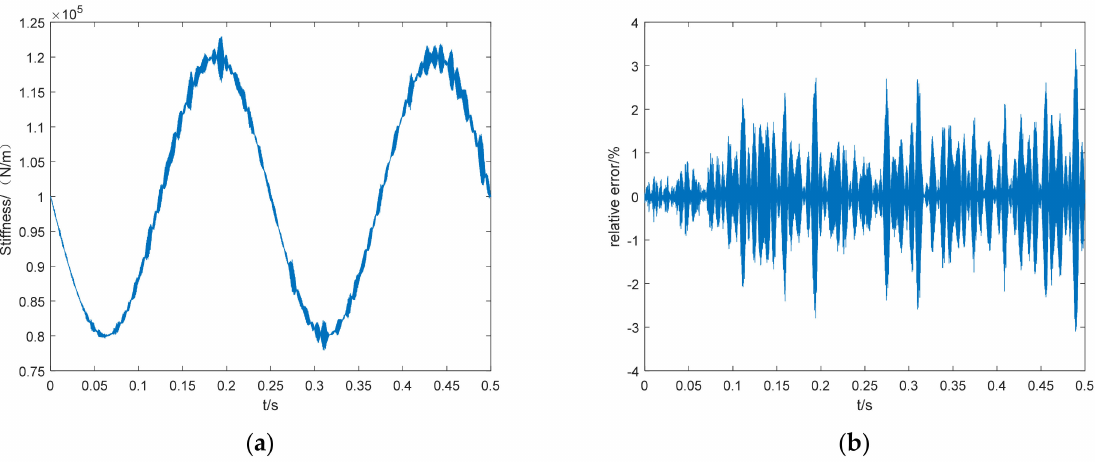
Figure 11. Time domain identification result ( a ) and relative error ( b ) of time-varying stiffness (cid:101) p 3 at 50 dB signal-to-noise